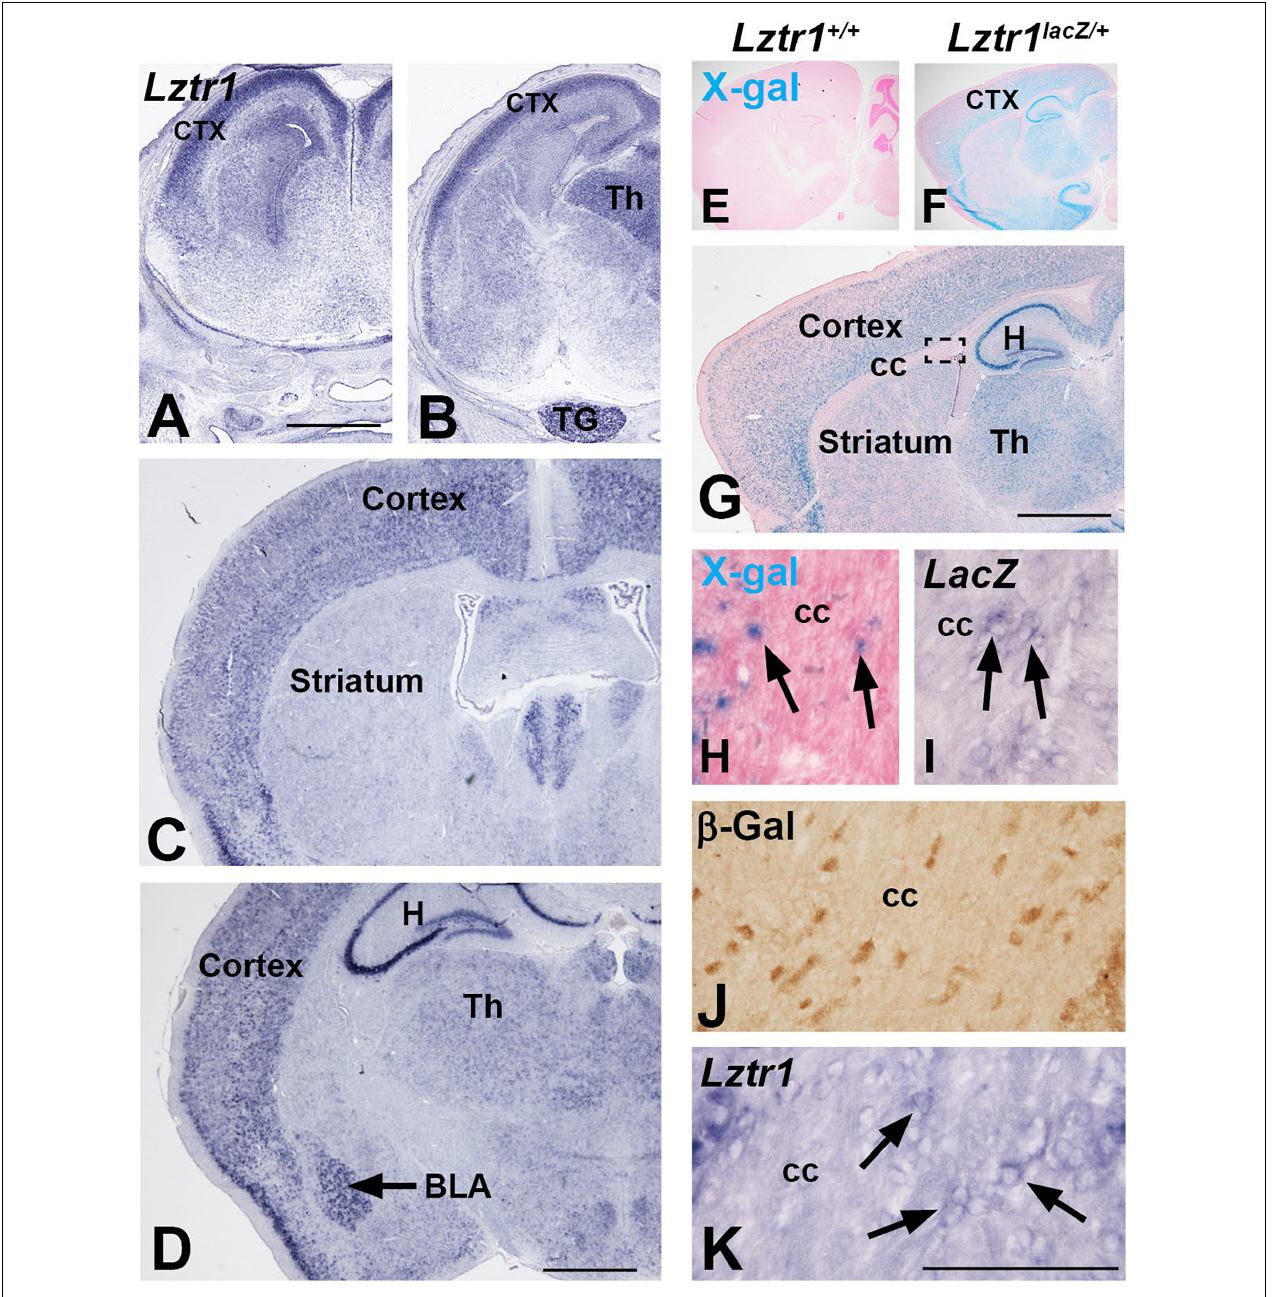
FIGURE 1 | Lztr1 expression in the developing telencephalon. Lztr1 gene expression in the cortex and thalamus at both E18.5 (A,B) and postnatal (1 month old) stages (C–K) . Lztr1 is also observed in the trigeminal nerve at E18.5 (B) and the hippocampus and basolateral amygdala in the postnatal brain (black arrow, D ). X-gal reaction in postnatal brains shows lacZ reporter activity from the Lztr1 locus (compare E to F ). Sagittal view of the postnatal forebrain shows that lacZ activity is similar to Lztr1 gene expression (compare G to C,D ). High magnification of the corpus callosum reveal LacZ-positive cells (H) , lacZ gene expression (I) , and β -gal immunohistochemistry (J) . This correlates to the Lztr1 expression observed in the corpus callosum (K) . Scale bars = 1 mm in for (A–D,G) . Scale bar is 100 µ m for (H–K) . ctx, cortex; Th, thalamus; TG, trigeminal nerve; H, hippocampus; BLA, basolateral amygdala; CC, corpus callosum.